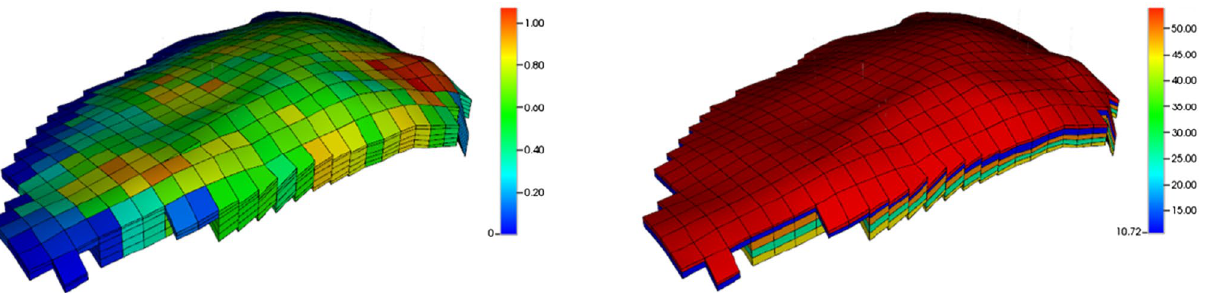
Fig. 6 PP C (left) and PP L (right) maps